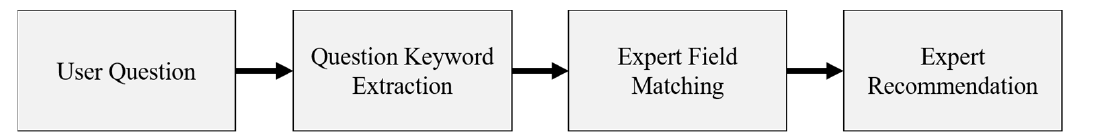
Figure 6. Procedure of expert recommendation.